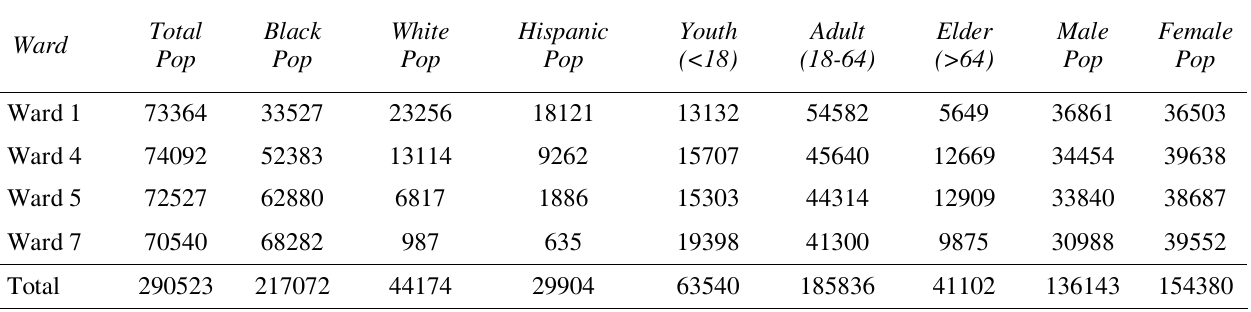
Table 1: 2000 Demographics for Four Wards of Washington, DC